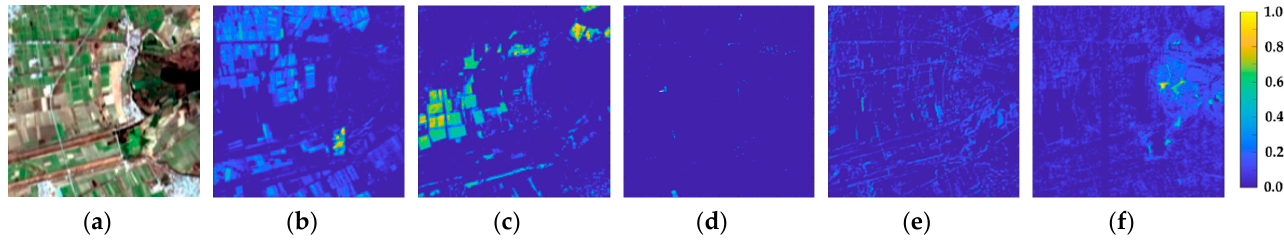
Figure 11. Different endmember abundance mapping obtained in ZY-1 02D HSI. ( a ) Color composite imagery; ( b ) vegetation; ( c ) soil; ( d ) blue-roofed building; ( e ) road; and ( f ) swamp.